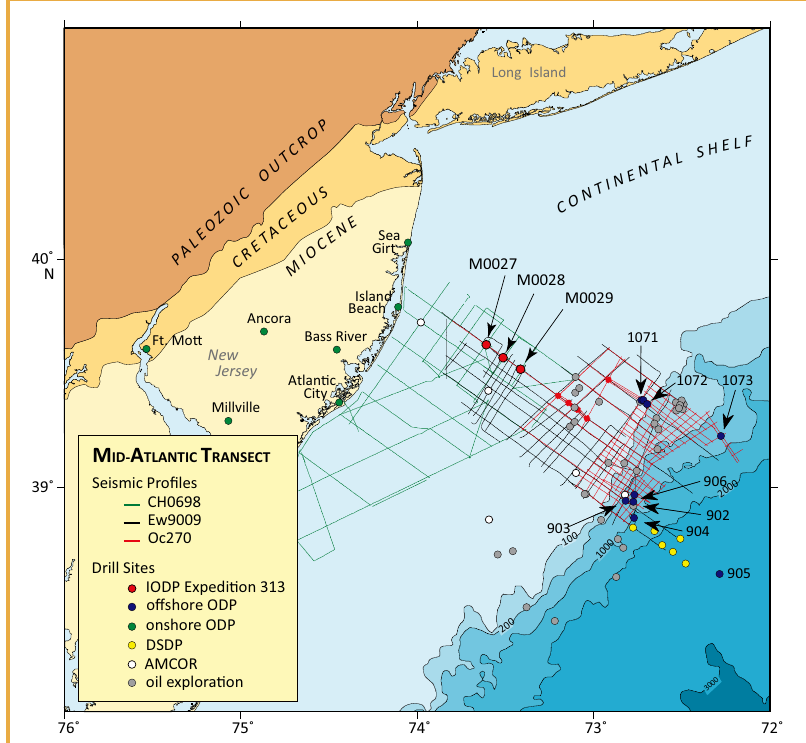
Figure 1. The New Jersey continental margin showing Sites M0027, M0028, and M0029 along with other completed boreholes both onshore and offshore. Tracks of reconnaissance seismic lines relevant to the goals of Expedition 313 are also